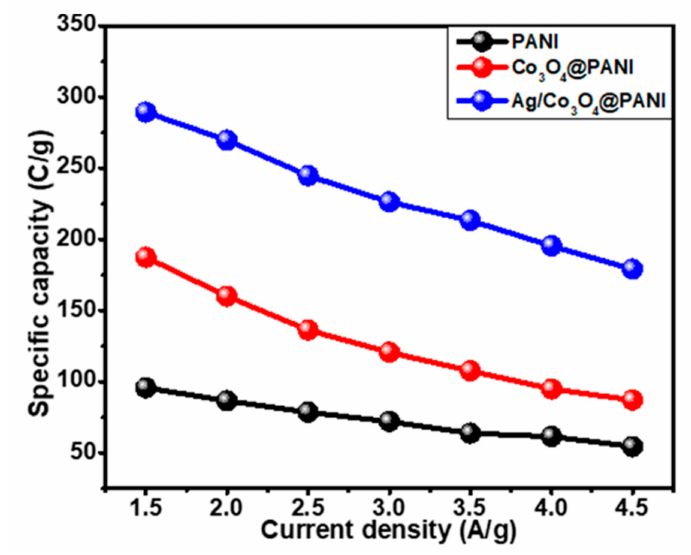
Figure 9. Specific capacity versus current density plot of PANI, Co 3 O 4 @PANI, and Ag / Co 3 O 4 @PANI